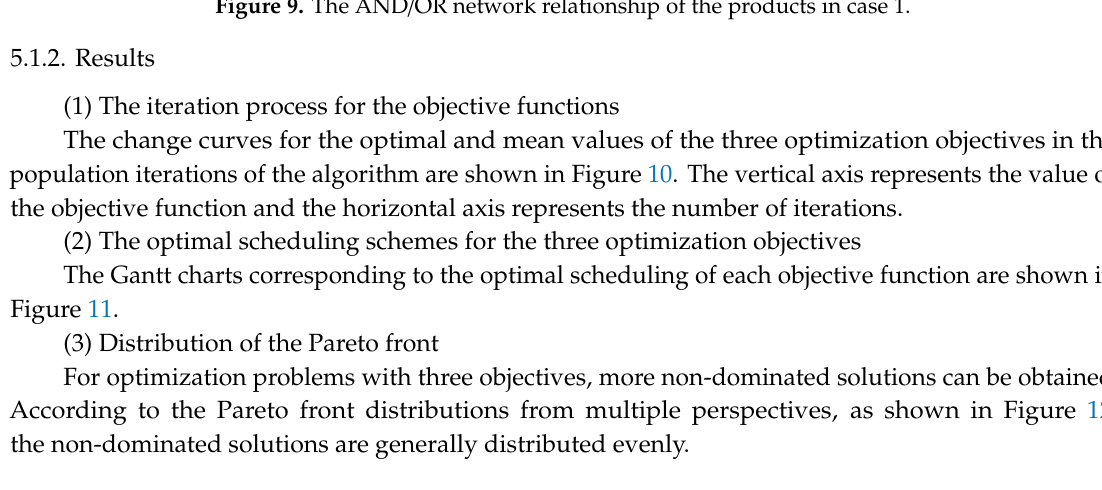
Figure 9. The AND / OR network relationship of the products in case